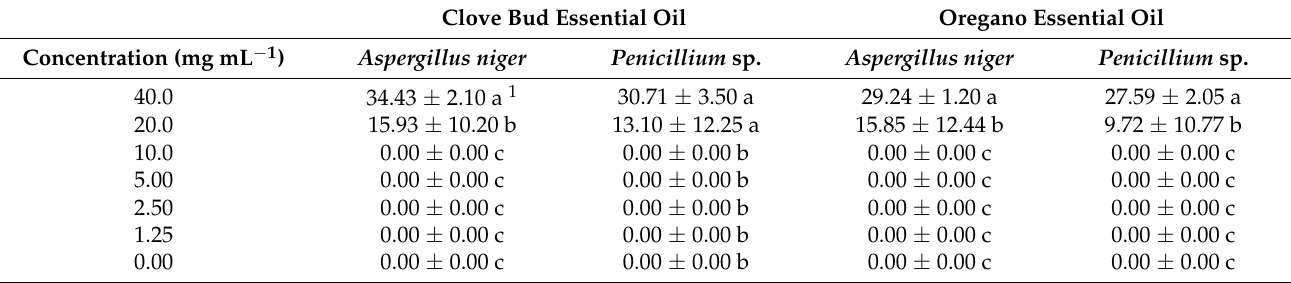
Table 2. Inhibition halos of Aspergillus niger or Penicillium sp. after 5 days of storage at 25 ± 2 ◦ C, as affected by clove bud or oregano essential oils [48]. Clove Bud Essential Oil Oregano Essential Oil Concentration (mg mL − 1 ) Aspergillus niger Penicillium sp. Aspergillus niger Penicillium